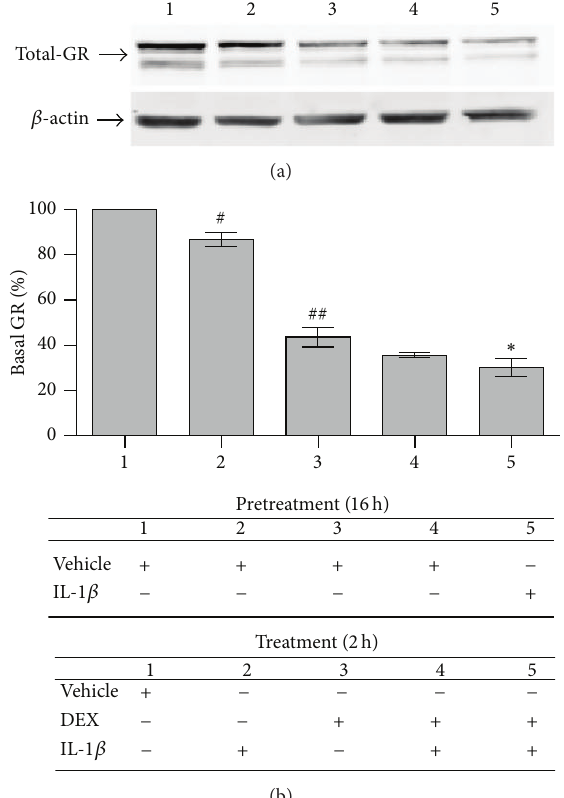
Figure 2: Sustained IL-1 𝛽 reduces the whole-cell GR protein level after a DEX challenge. Cells were pretreated for 16h with either vehicle or 5 ng/mL IL-1 𝛽 and then treated for 2 h with vehicle (b1, veh/veh), 5 ng/mL IL-1 𝛽 alone (b2, veh/IL-1 𝛽 ), 10 −8 M DEX alone (b3, veh/DEX), simultaneous addition of 5 ng/mL IL-1 𝛽 + 10 −8 M DEX (b4, veh/IL-1 𝛽 + DEX) or sustained IL-1 𝛽 conditions (b5, IL-1 𝛽 /IL-1 𝛽 + DEX), as indicated in the table. Whole cell lysates were prepared and analyzed by Western blot with anti-GR and - 𝛽 -actin antibodies. (a) Blots of a representativeexperiment( 𝑛 = 3 ).(b)QuantitationofwholecellGRproteinbydensitometry.Dataarerepresentedasmean ± SEMpercentage of total GR protein amount as compared to veh/veh treatment. # 𝑃 < 0.05 and ## 𝑃 < 0.005 , difference in GR protein levels between veh/IL- 1 𝛽 -treated (b2) or veh/DEX-treated (b3) and veh/veh-treated cells (b1), respectively. ∗ 𝑃 < 0.05 , difference in GR protein levels